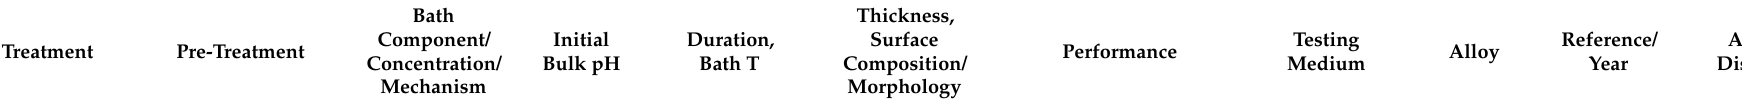
Table 3. Overview of the selected conversion coating procedures reported in the